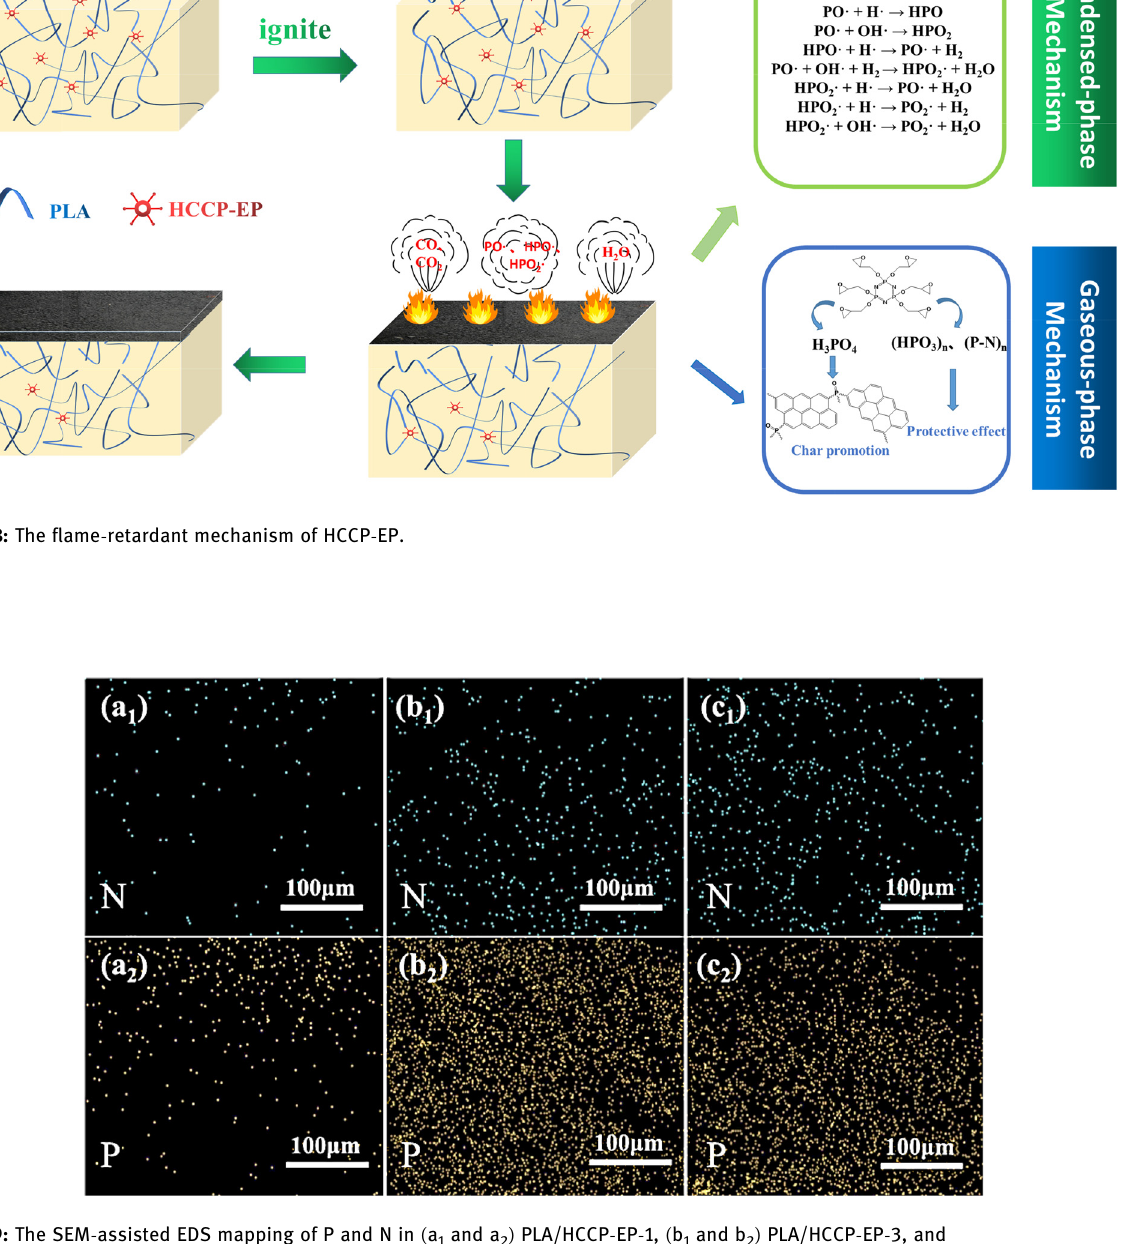
Figure 9: The SEM - assisted EDS mapping of P and N in ( a 1 and a 2 ) PLA/HCCP - EP - 1, ( b 1 and b 2 ) PLA/HCCP - EP - 3, and ( c ) PLA/HCCP - EP - 5. 1 and c 2